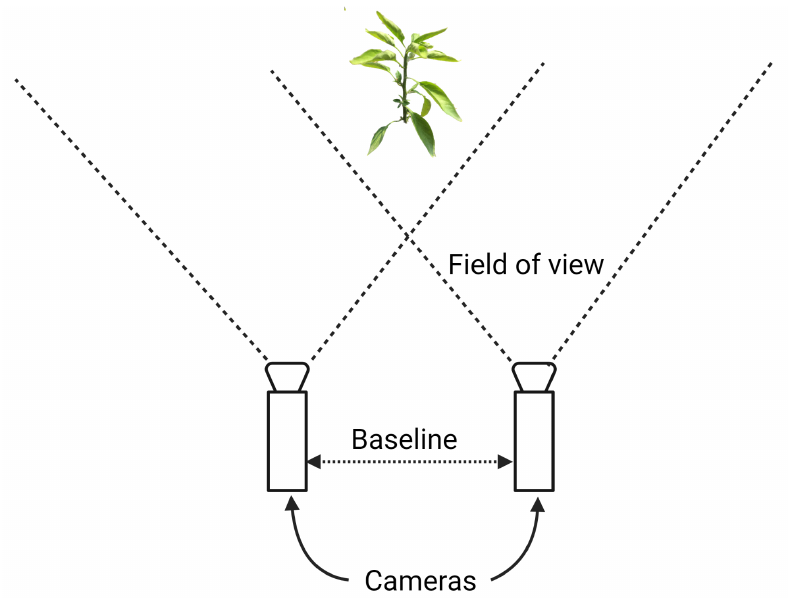
Figure 6. Stereo vision